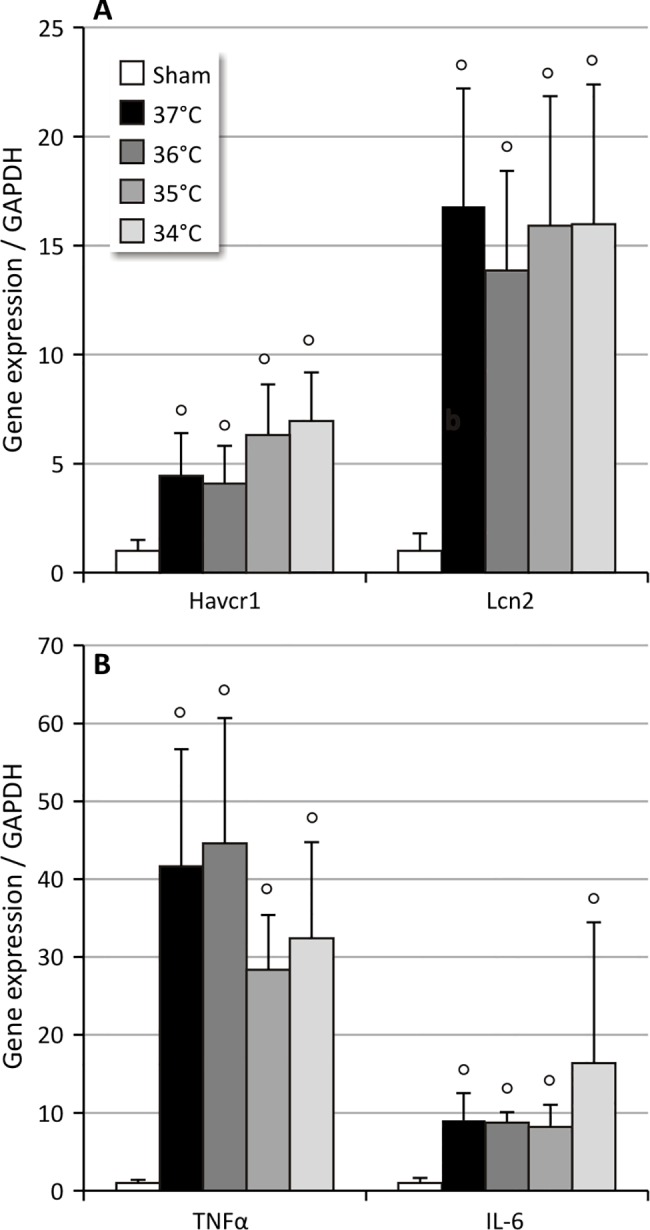
Relative quantification of long-term IRI-induced expression of tubular injury and inflammatory markers.°: p<0.05 vs. Sham UIRI was performed for 30 minutes at 37°C (n = 5), 36°C (n = 4), 35°C (n = 10) or 34°C (n = 5) and animals were euthanized 12 weeks after UIRI. A: Twelve weeks after UIRI, a significant increase in gene expression of tubular injury markers Havcr1 (KIM-1) and Lcn2 (NGAL) was observed in renal cortex tissue in all core body temperature conditions tested. B: Twelve weeks after UIRI, a significant increase in gene expression of inflammatory cytokines TNFα and IL-6 was observed in renal cortex tissue in all core body temperature conditions tested. The bars are the means ± s.d. The data were analysed using a two-tailed Mann-Whitney U test.